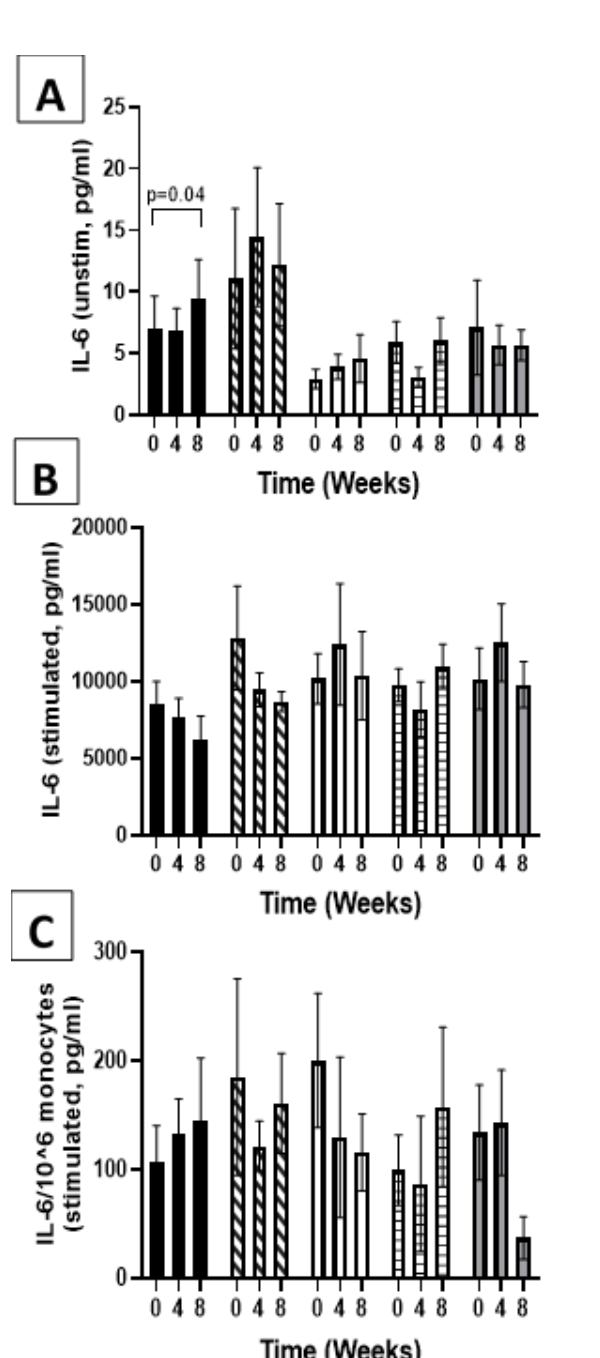
Figure 5. Plasma IL-6 without stimulation ( A ) and with lipopolysaccharide stimulation ( B ). ( C ) Stimulated samples normalized to monocyte numbers. Values are mean ± SEM, n = 15 per group. Significant changes are indicated where p < 0.05.